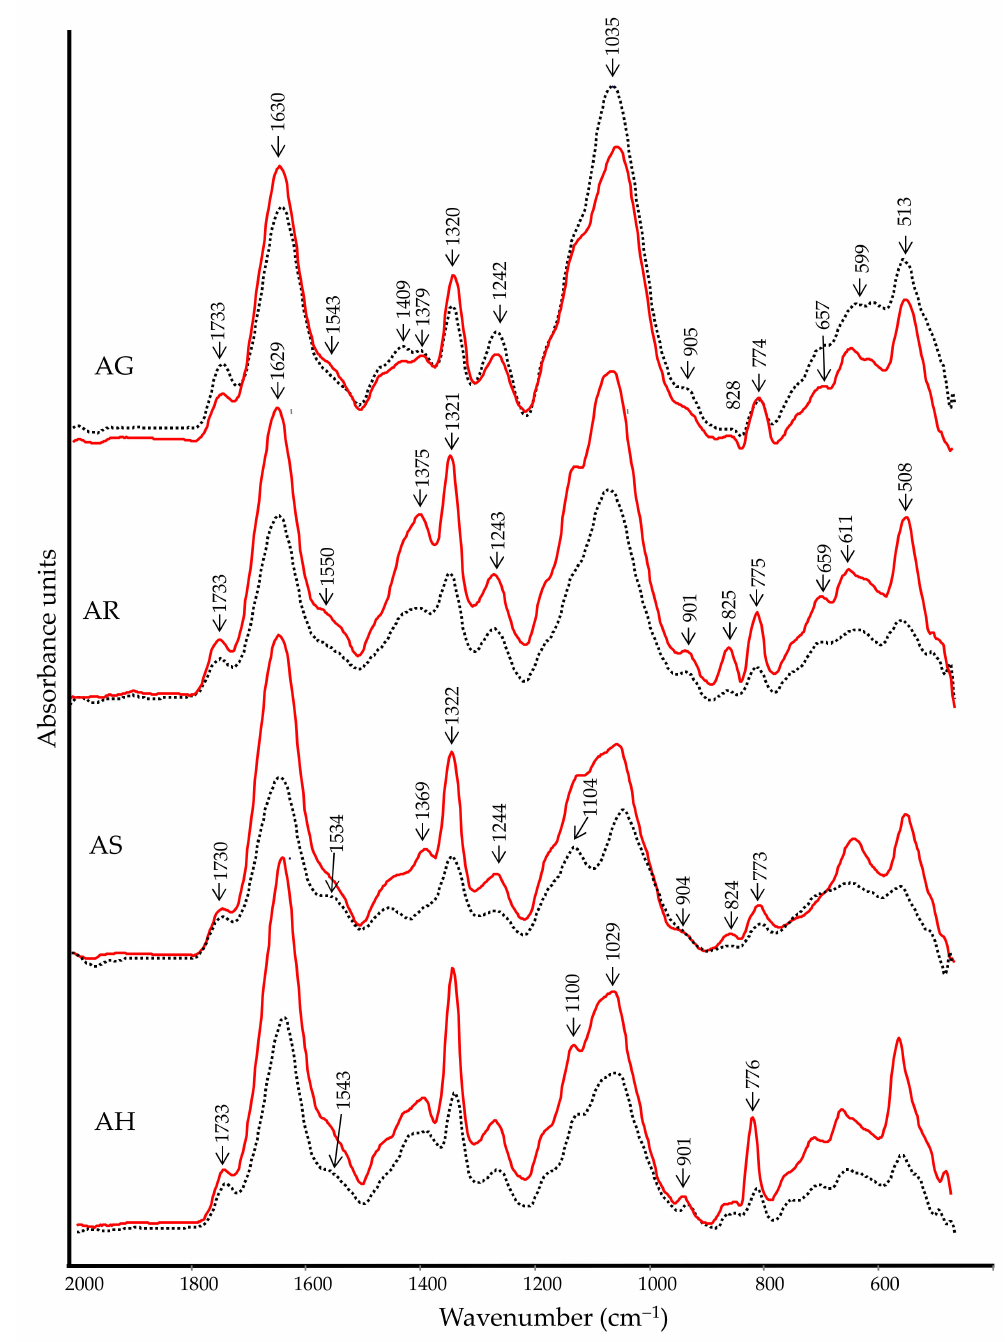
Figure 8. FTIR-ATR spectra of A. hortensis cv. green ( AG ), cv. red ( AR ), cv. scarlet ( AS ), and A. halimus ( AH ) samples under control (red line) and 360 mM water salinity (black dotted line) in the 1800 and 400 cm − 1 wavelengths